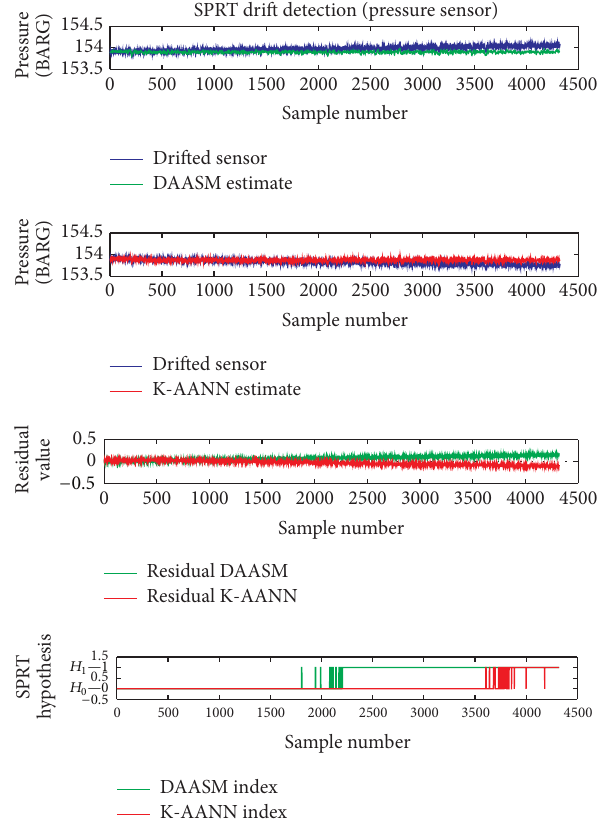
Figure16:SPRTbasedfaultdetectioninpressurizerpressuresensor.